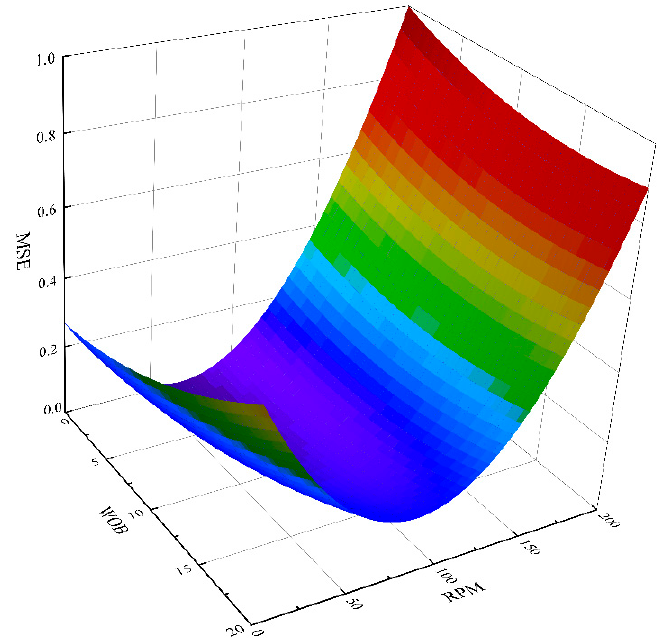
Figure 5. MSE—Avoid low WOB and high RPM.